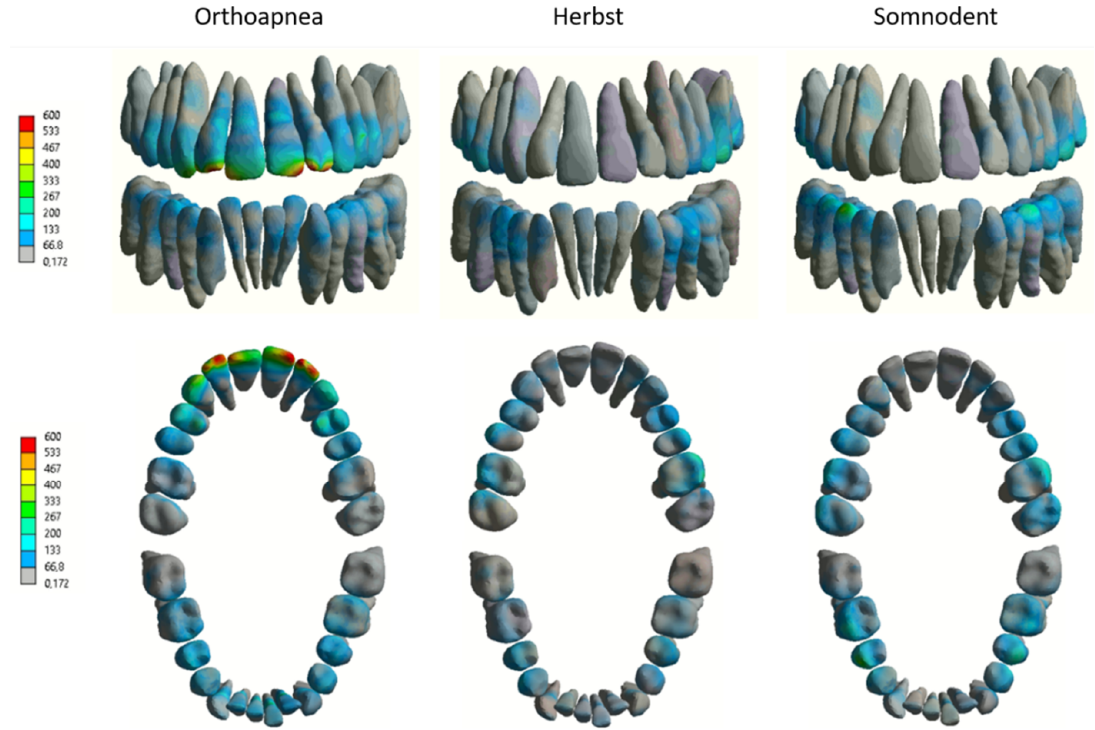
Figure 4. Colour plots. Stress distribution (kPa) in the teeth, frontal and occlusal view.